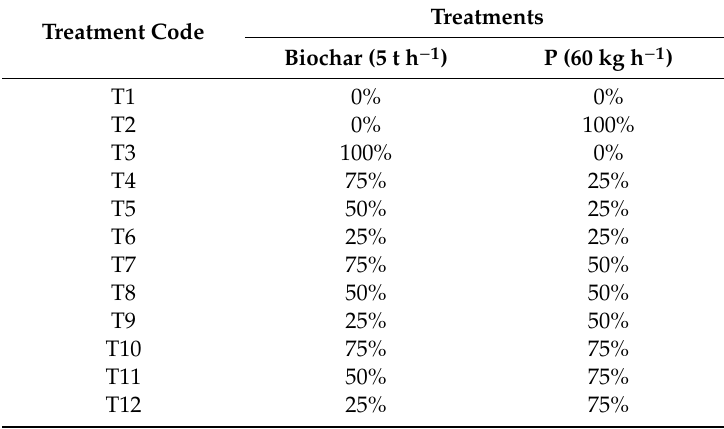
Table 1. Percentages of chicken litter biochar, nitrogen, phosphorus, and potassium fertilizers.